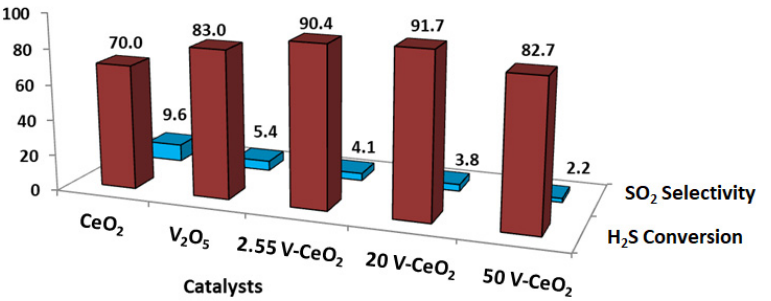
Figure 2. Catalytic performance of the different catalysts under steady-state conditions (T = 327 °C, H 2 S = 10 vol%, contact time = 0.6 s).